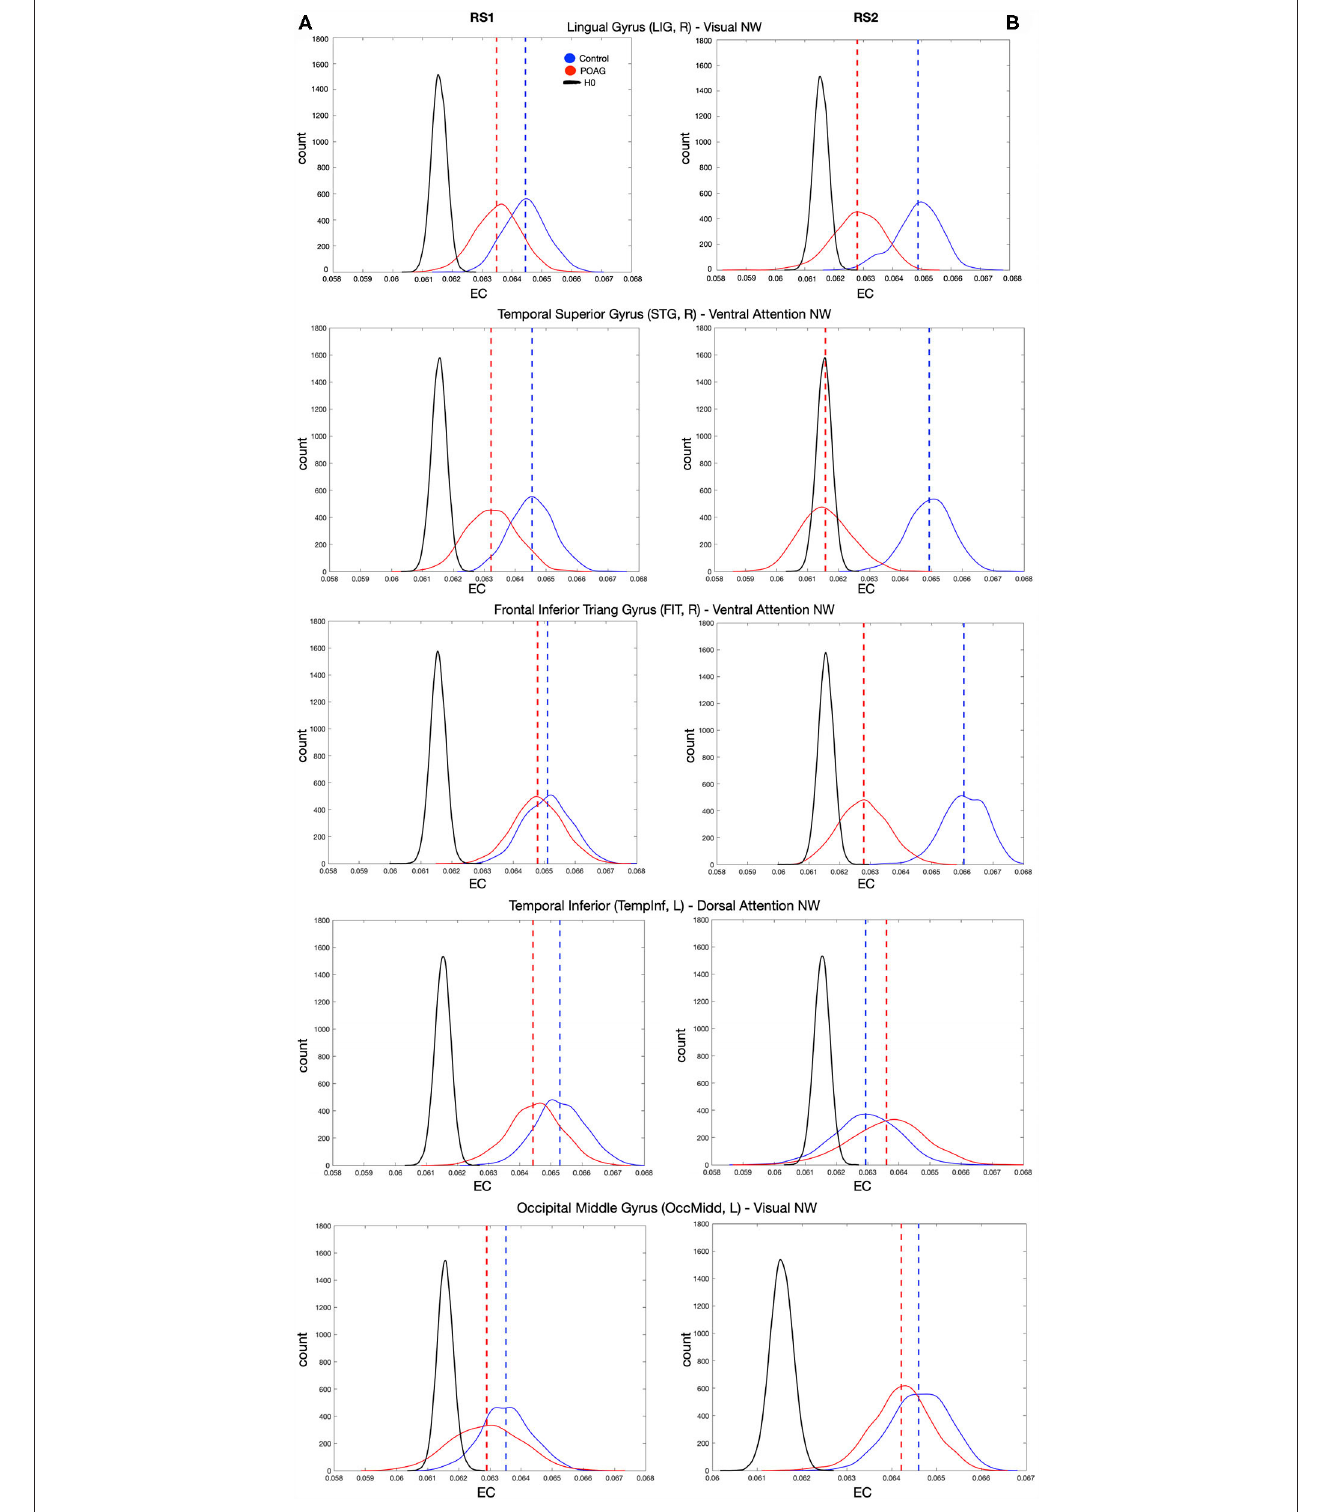
FIGURE 4 | EC values of various hubs present in both RS scan of both POAG and controls groups. Eigenvector centrality values of the hubs that were present in the RS scans for healthy and glaucoma groups (dashed lines), bootstrapped distributions (solid and dotted lines) and surrogate distributions for healthy and glaucoma (black lines) are reported for RS1 and RS2 in Panels (A,B) , respectively. Note that the surrogate distributions for healthy and glaucoma participant groups are overlapping and indicated by H0 in the figure legend. For all panels, “count” represents the eigenvector centrality values.